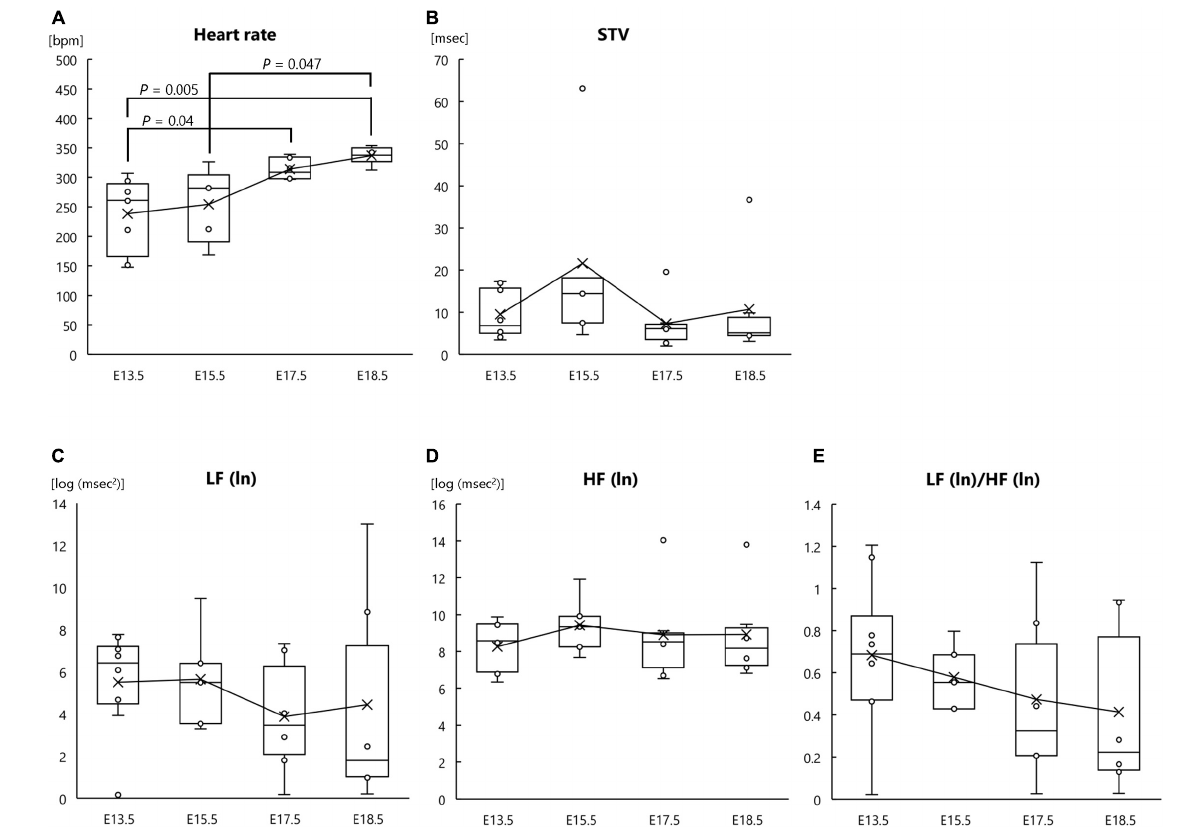
FIGURE 2 | Heart rate and autonomic nervous activities at each gestational age in pregnant mother mice. (A) Heart rate, (B) short-term variability (STV), (C) natural logarithm of the low-frequency of the power spectrum [LF (ln)], (D) natural logarithm of the high-frequency of the power spectrum [HF (ln)], and (E) LF (ln)/HF (ln) ratio at the following gestational ages: E13.5 ( n = 8), E15.5 ( n = 5), E17.5 ( n = 6), and E18.5 ( n = 6). ECG signals were measured in pregnant mothers and fetuses at each gestational